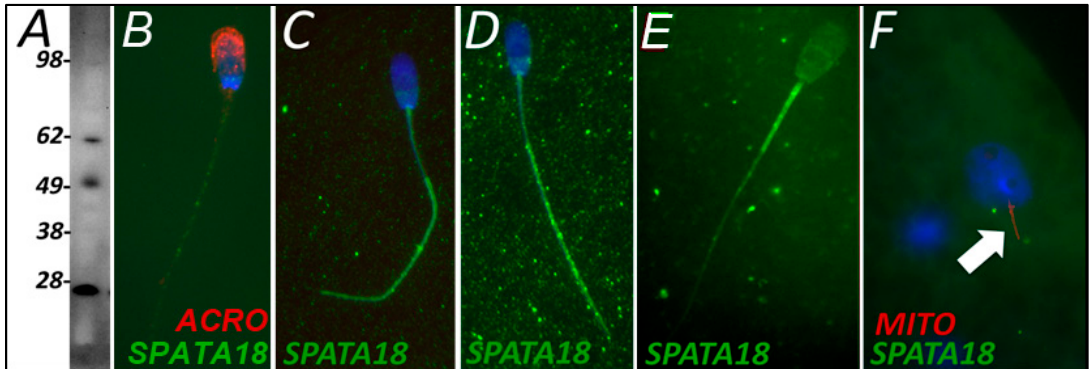
Figure 4. SPATA18 was detected in freshly ejaculated, and cell-free system treated spermatozoa ( A – E ) and zygotes ( F ) using Western blotting ( A ) and immunocytochemistry ( B – E ). ( A ) Western blotting detected a band consistent with the predicted mass in S. scrofa (59 kDa), as well as several lower bands likely resulting from protein degradation. Fresh ejaculated spermatozoa appeared to have the tail and postacrosomal sheath labeling present ( B ). Within the cell-free system, primed and buffer exposed spermatozoa appeared to have SPATA18 localized throughout the tail but mainly to its principal piece ( C ). After 4 h of cell-free exposure, spermatozoa displayed a seemingly identical localization pattern ( D ). After 24 h of cell-free system exposure, the localization pattern shifted from sperm tail principal piece to midpiece/mitochondrial sheath ( E ). However, SPATA18 was no longer detectable in a one-cell zygote ( F ).